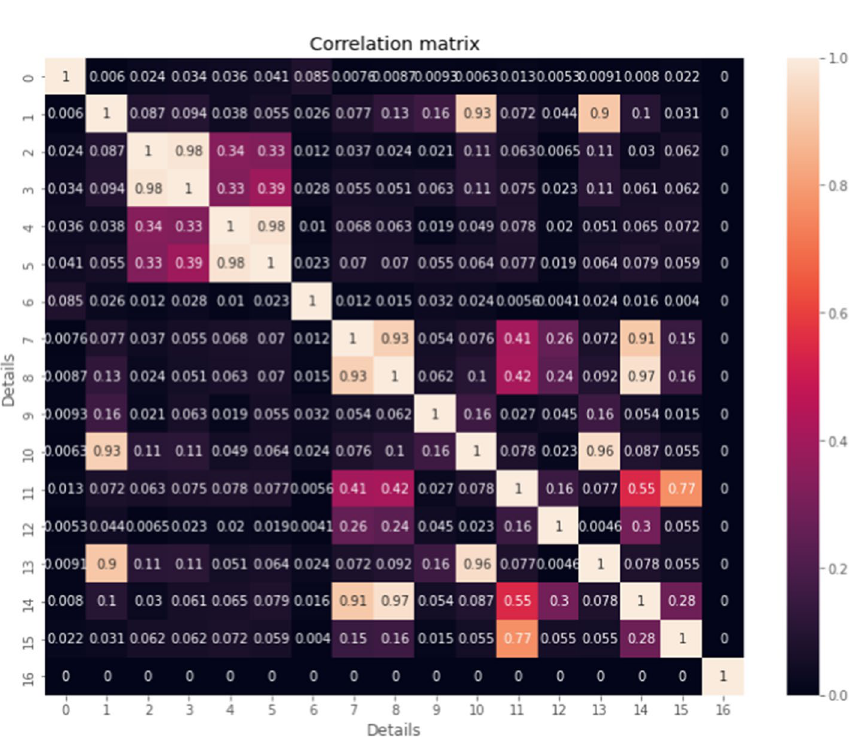
The values are normalised for easy